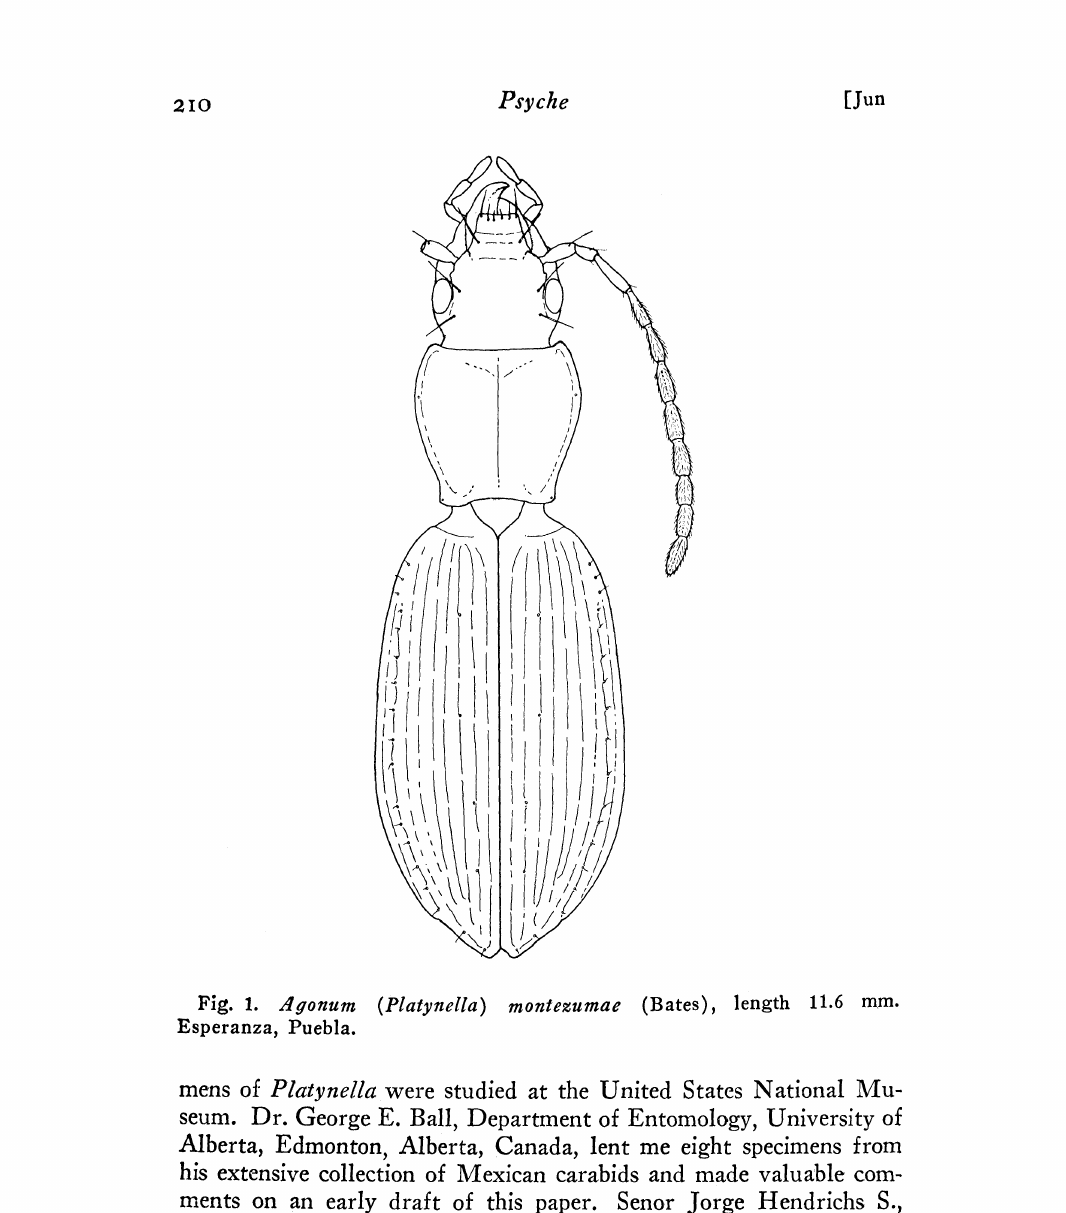
Fig. 1. lgonum (Platynella) montezumae (Bates), length 11.6 mm. Esperanza,